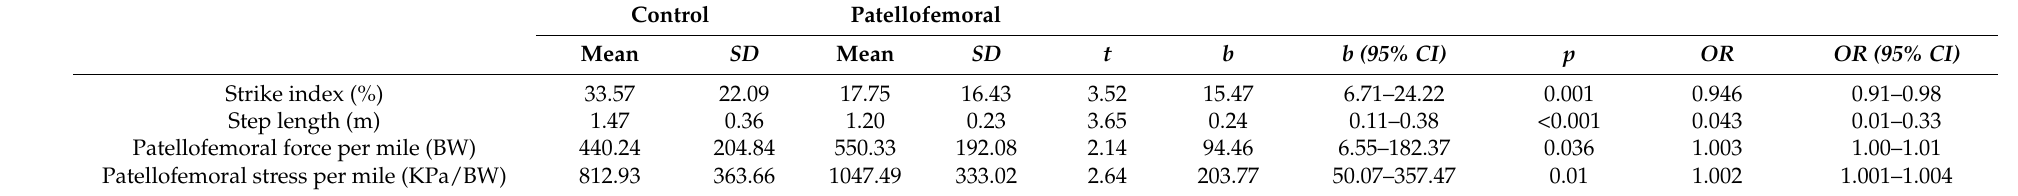
Table 3. Joint loading and temporal indices in overall PFP participants and controls.